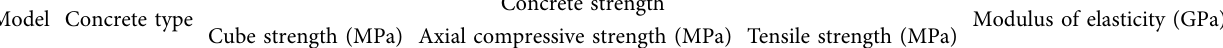
Table 2: Mechanical performance index of